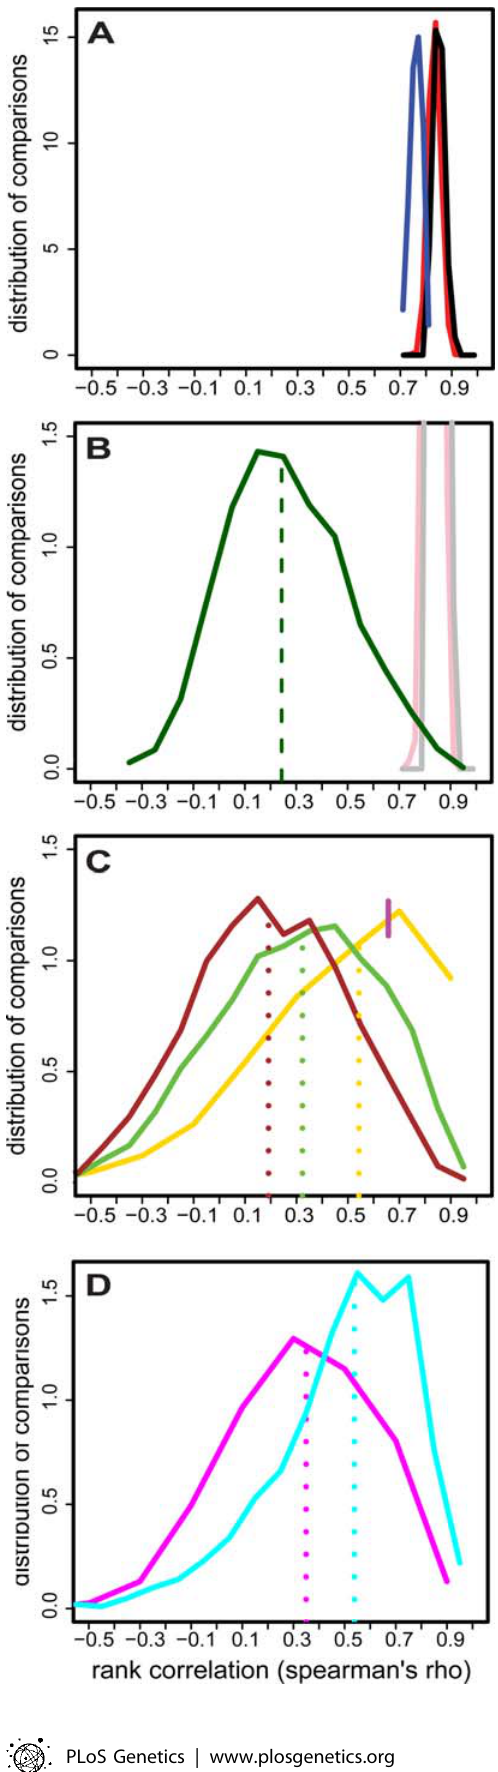
of genes was correlated to ATP levels (Figure 4B). In total, over